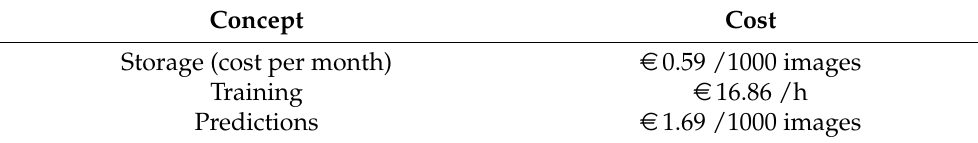
Table 1. Azure Custom Vision storage, training and prediction